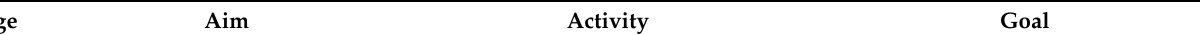
Table 2. Return to Riding guidelines, adapted from the Fifth International Conference on Concussion in